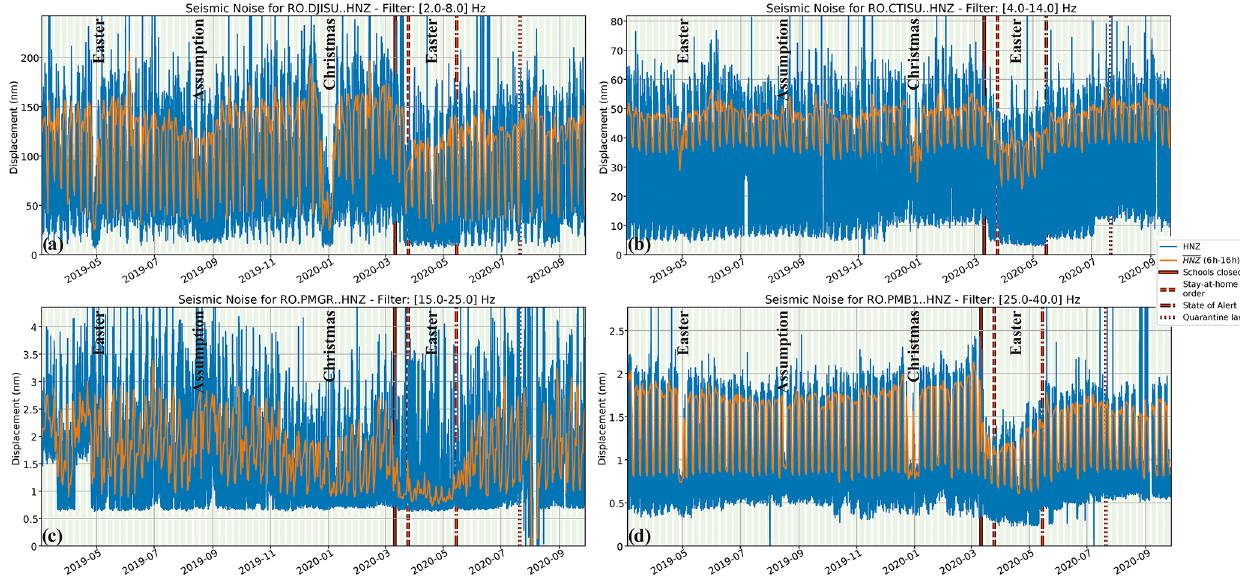
Figure 3. Long-term evolution of DRMS in four different frequency bands observed at the stations: (a) DJISU (2–8Hz), (b) CTISU (4– 14Hz), (c) PMGR (15–25Hz), and (d) PMB1 (25–40Hz). The locations of the stations are displayed in Fig.